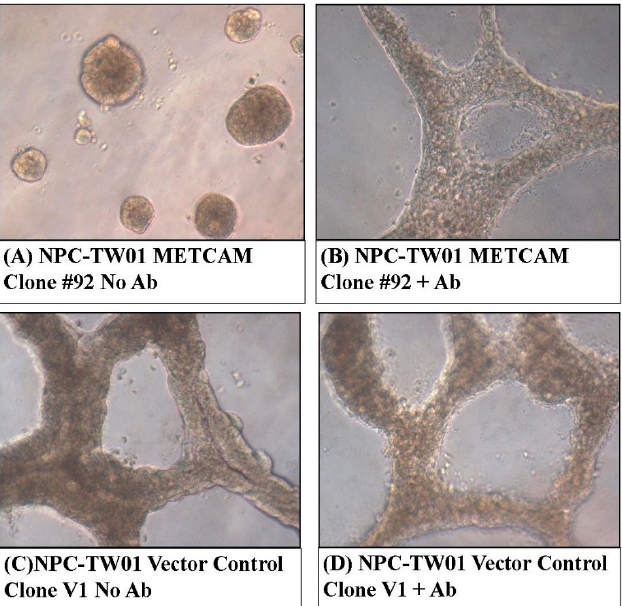
Figure 4. Effects of huMETCAM/MUC18 ′ s over-expression on the growth of the NPC-TW01 cells in the 3D basement membrane culture assay. The growth of the cells from the METCAM clone #92 and the control clone V1 in the 3D basement membrane was observed after 2–9 days and photographed as described in the Section 4. ( A , B ) show the growth of METCAM clone #92 in the absence or the presence of the anti-huMETCAM/MUC18 antibody, respectively. ( C , D ) show the growth of the vector control clone V1 in the absence or the presence of the anti-huMETCAM/MUC18 antibody, respectively.